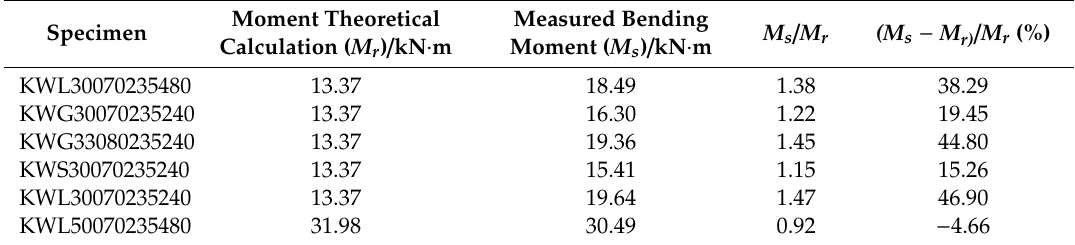
Table 5. Ultimate bending moment of all specimens.